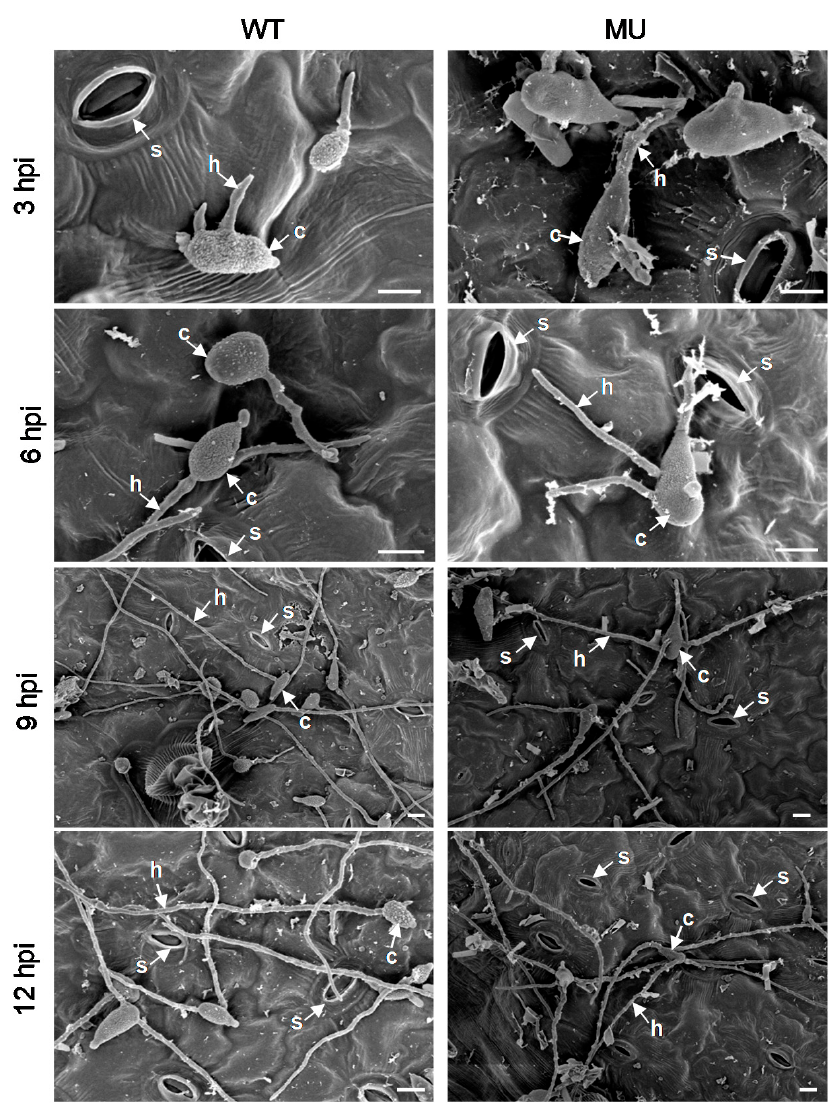
Figure 2. Comparison of germination and development of A. alternata wild-type (WT, left) and mutant ∆ HP001 (MU, right) conidia (8 × 10 5 conidia mL − 1 ) on the surface of A. adenophora leaves. Scanning electron micrographs were shown at 3, 6, 9, and 12 h post inoculation (hpi). Note that no differences between MT and MU were present during germination of conidia and growth of hyphae at the early-stage infection. Here, s: Stomata; c: Conidium; h: Hypha. Scale bars = 10 μ m. One representative result out of three repetitions is presented.